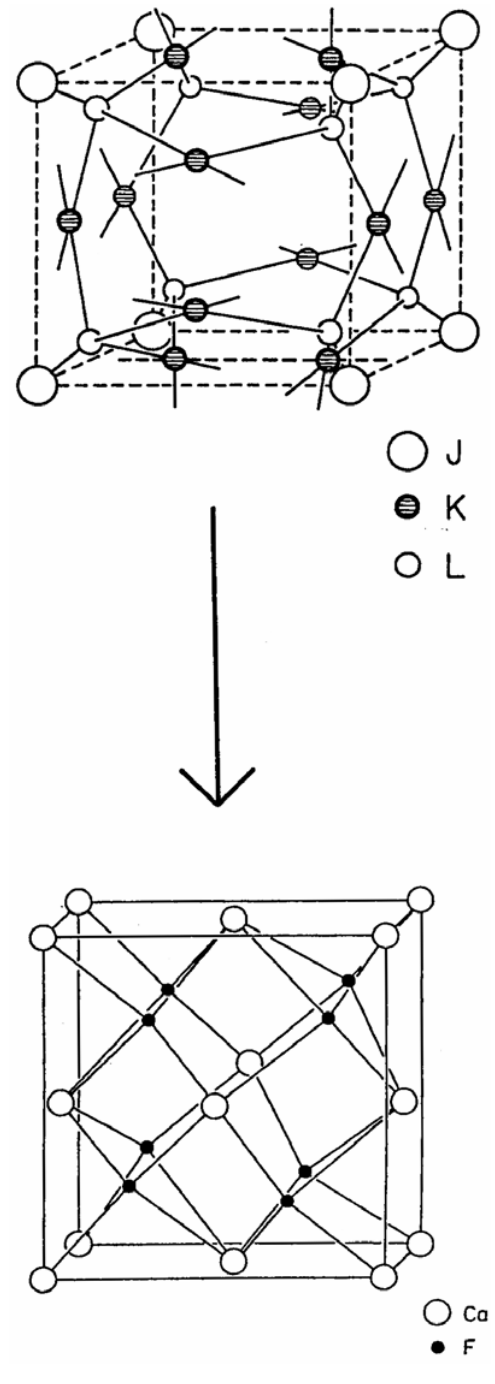
Figure 6. Continuous structural transformation of jubilite into